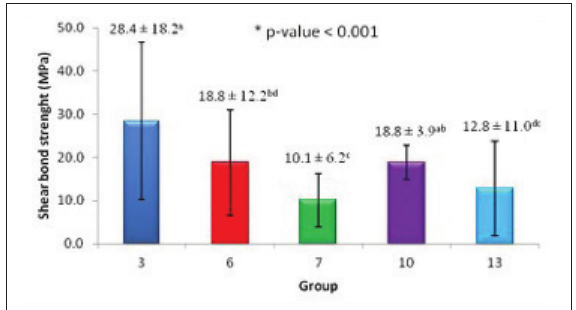
Figure 5. The effect of treatment with bromelain plus papain gel on shear bond strength in comparison with all the conditions of etching and fixation